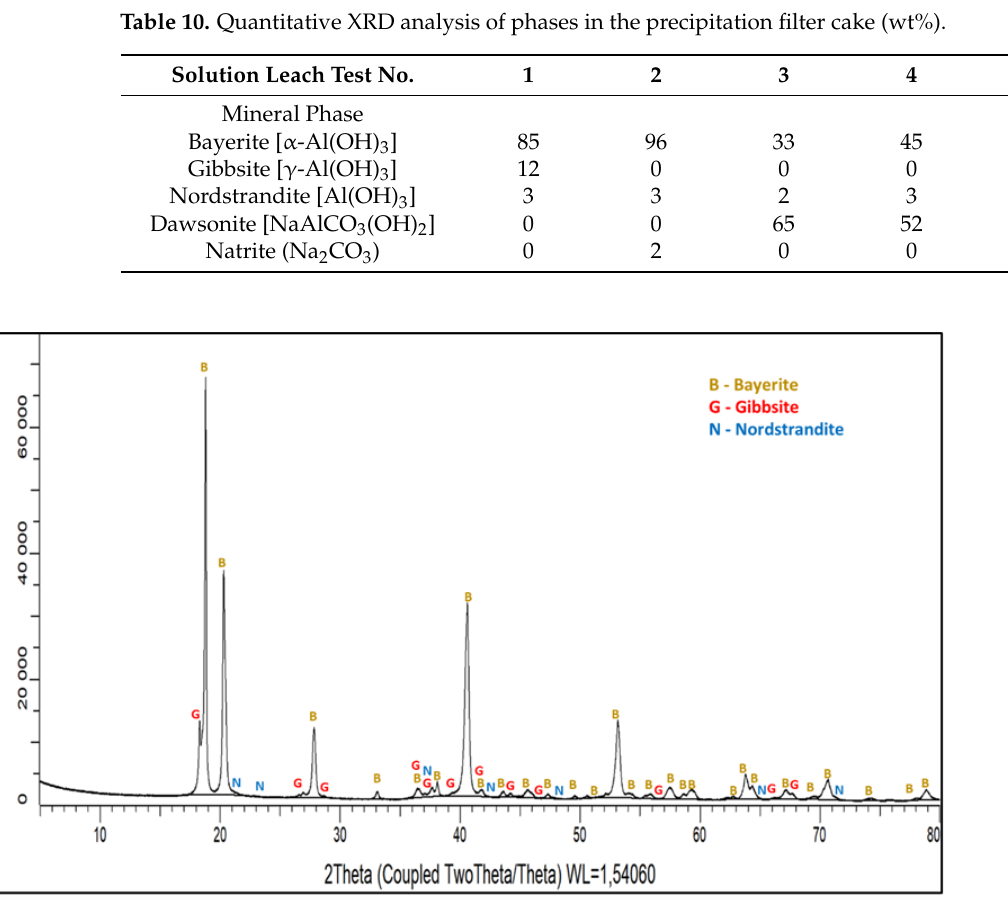
Figure 14 . XRD spectrum for precipitate from test no. 1. Figure 14. XRD spectrum for precipitate from test no.